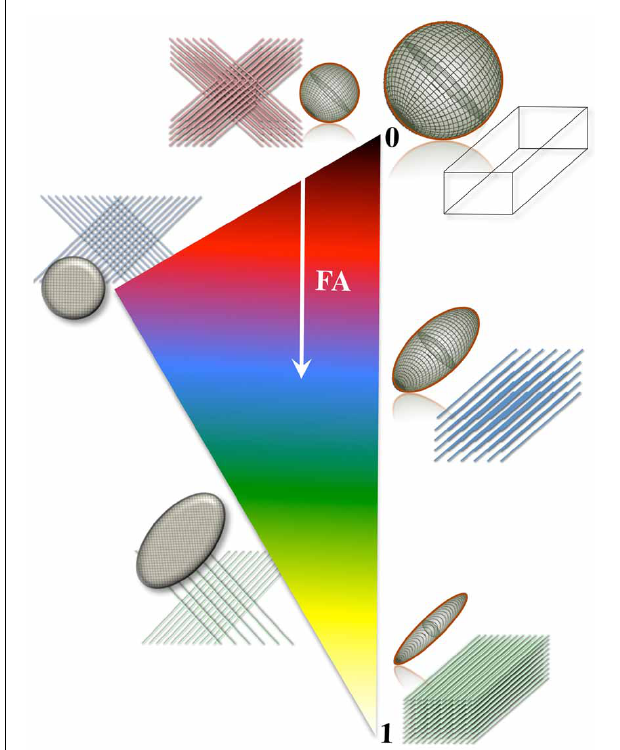
FIGURE 3 | Differential tensor behaviors in white matter. Cell membranes are thought to be the main restricting boundary to water mobility in white matter. As such, the ratio of axial to radial diffusivities, commonly described by a metric known as “fractional anisotropy” (FA), can reflect the coherence (sometimes thus the integrity) of packed axons in white matter. FA approaches one in well-organized tracts, where the diffusion ellipsoid is elongated along the principal tract orientation; and tends to zero, in less coherent environments—i.e., in heterogeneous areas of many crossing fibers, and in gray matter or cerebrospinal fluid—, where the ellipsoid resembles a sphere. In the full complexity of white matter microstructure, however, the ellipsoid can take a wider range of geometries from that of a rugby ball to that of surfboard or a dish—with the degree of sphericity and planarity dictated primarily—but not only—by axon packing density, degree of myelination and/or the geometrical arrangement of crossing, kissing and/or splaying fiber